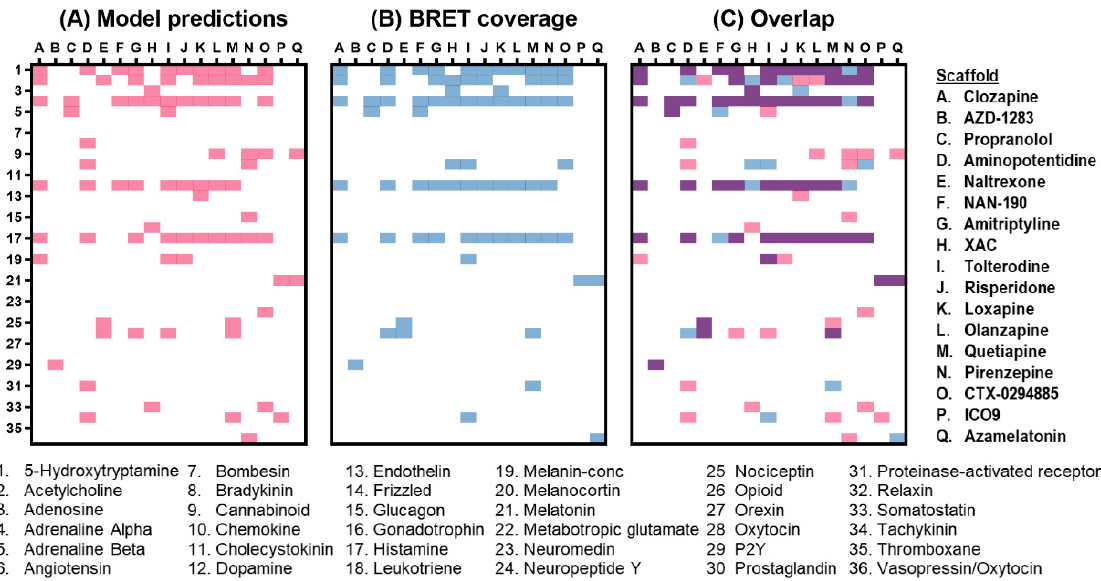
Figure 7. Machine learning predictions for GPCR-ligand interactions versus empirical NanoBRET screens. ( A ) Machine learning predictions for interactions between scaffolds A–Q (specified on the right) and 36 GPCR families. For each scaffold, predictions receiving a classification probability ≥ 4% were considered a positive interaction and are shown in red, with predicted negative interactions in white. ( B ) Empirical NanoBRET evaluations across the 36 GPCRs families using fluorescent tracers. For each scaffold, confirmed interactions with ≥ 1.5-fold response are shown in blue and negative or unconfirmed interactions are shown in white. ( C ) Concordance between machine learning predictions and NanoBRET screens. Confirmed predictions are shown in purple.